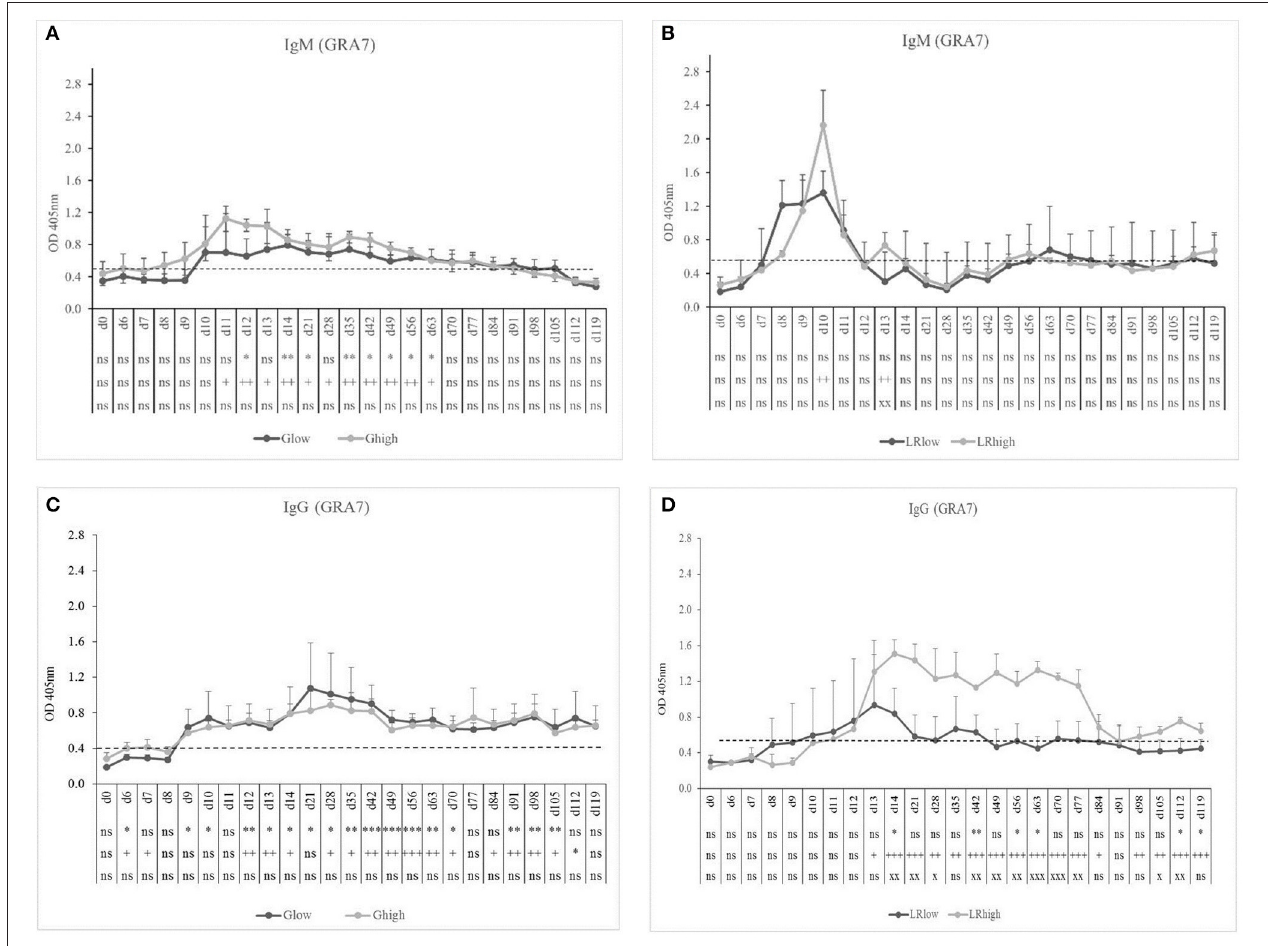
FIGURE 2 | GRA7-specific IgM and IgG responses after inoculation with IPB-G or IPB-LR T. gondii strain. IgM (A,B) and IgG (C,D) responses in animals inoculated with a low or a high dose of the IPB-G (A,C) or the IPB-LR (B,D) strain. Groups: G low , G high , LR low , LR high . The horizontal dashed line indicates the cut-off value based on the mean of the negative animals. The results represent a mean of the infected group ± SD; * (low dose vs. controls) or + (high dose vs. controls) or x (low dose vs. high dose): P < 0.05, ** or ++ or xx: P < 0.01; *** or + + + or xxx: P < 0.001; ns, not significant.